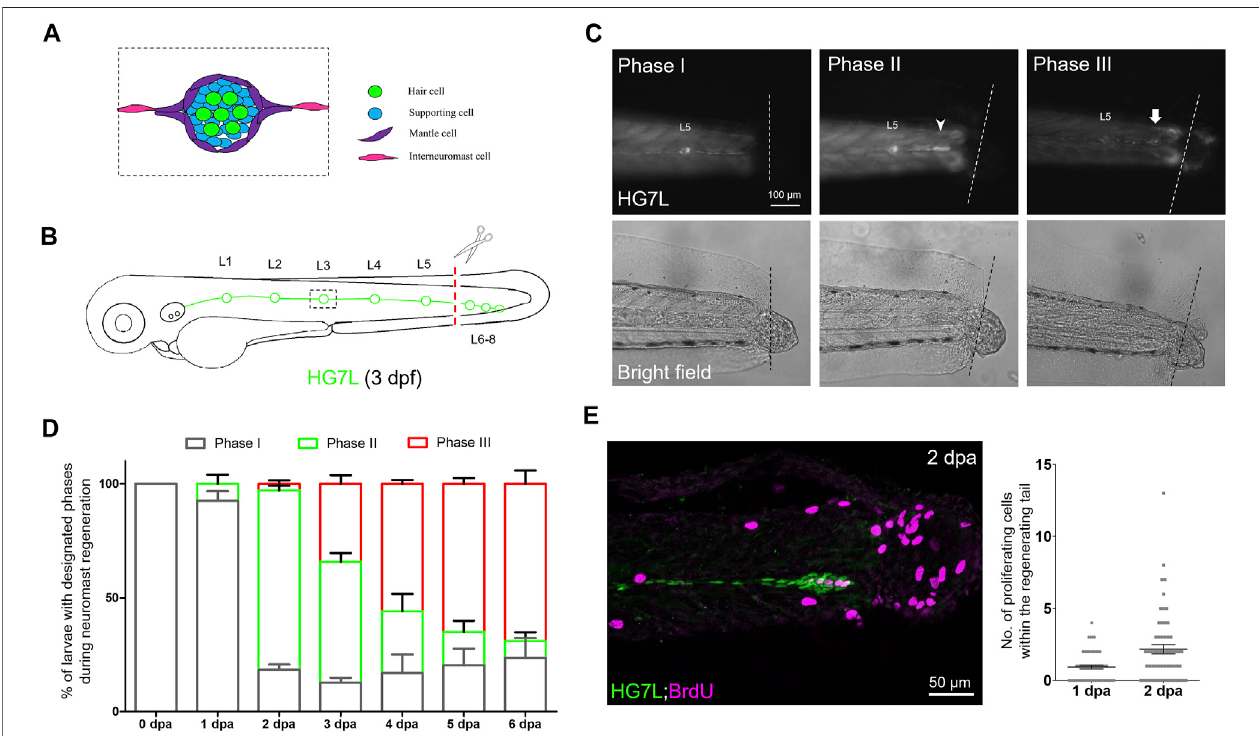
FIGURE 1 | Active cell proliferation and clustering occur during neuromast regeneration upon fi n amputation. (A) A cartoon shows different cell types in a neuromast of the lateral line. (B) A graph shows only one side of the fl uorescent posterior lateral (green) with L1-8 neuromasts of an Et(HG7L) larva at three days post- fertilization. The tail fi n is clipped at the dashed line to remove neuromast L6-8. (C) A new neuromast was regenerated in three distinct phases as examined at the GFP channel under epi fl uorescent microscopy. Phase I: No notable increase in fl uorescent cells was observed in the lateral line between the L5 neuromast (as labeled) and the cut site (dotted line). Phase II: Fluorescent cells were increased and aggregated to form a cluster (arrowhead). Phase III: A new neuromast was formed (arrow). The corresponding bright- fi eld images for each phase are shown below. (D) The percentages of larvae at each phase were calculated on the designated day postamputation (dpa, N = 3, n =70). (E) Et(HG7L) larvae were fi n-amputated, fi xed at 1and 2dpa,and subjected toBrdU or EdU staining (in magenta)to probe actively proliferating cells or GFP immunohistochemistry (in green) to stain lateral line. Active cell proliferation was observed near the cutting edge at 2 dpa and quanti fi ed in a scatter plot on the